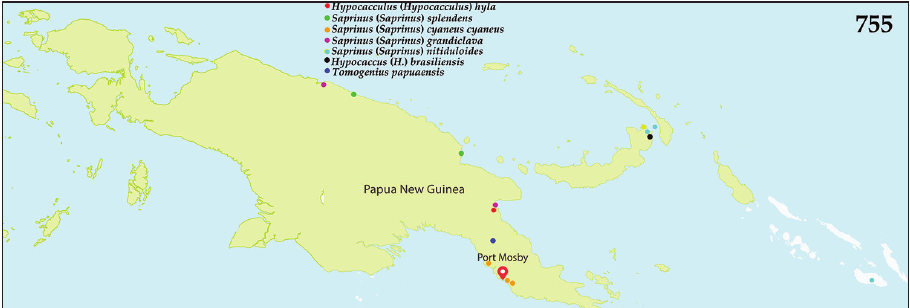
Figure 755. Distribution of Saprininae in New Guinea and Solomon Islands: Hypocacculus ( Hypocacculus ) hyla (Marseul, 1864) (New Guinea); Hypocaccus ( Hypocaccus ) brasiliensis (Paykull, 1811) (New Guinea: New Britain); Saprinus ( Saprinus ) cyaneus cyaneus (Fabricius, 1775) (New Guinea); Saprinus ( Saprinus ) grandiclava Kanaar, 1989 (New Guinea); Saprinus ( Saprinus ) nitiduloides Fairmaire, 1883 (New Guinea: New Britain; Solomon Islands); Saprinus ( Saprinus ) splendens (Paykull, 1811) (New Guinea) and Tomogenius papuaensis Gomy, 2007 (New Guinea).